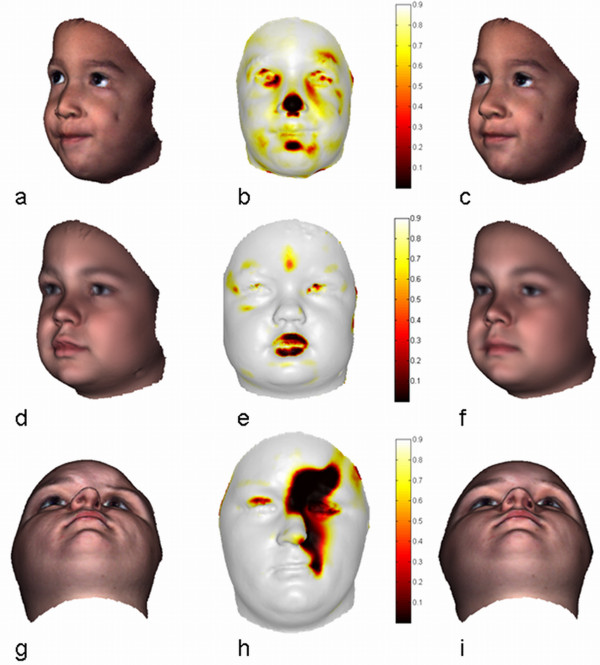
Facial discordancy of craniofacial disorders & syndromes. From left to right: original facial surface, dysmorphogram of facial discordancy and norm-equivalent. From top to bottom: assessment of persons with mild Treacher-Collins syndrome, a Lysosomal Storage Disorder and a Parry-Romberg syndrome. A general note: eyes and areas in the face covered by hair, e.g. eyebrows, always contain 3D surface mesh-artifacts (due to limitations of current scanning technology) such that spurious outliers are visible in these areas. These are to be interpreted with caution.